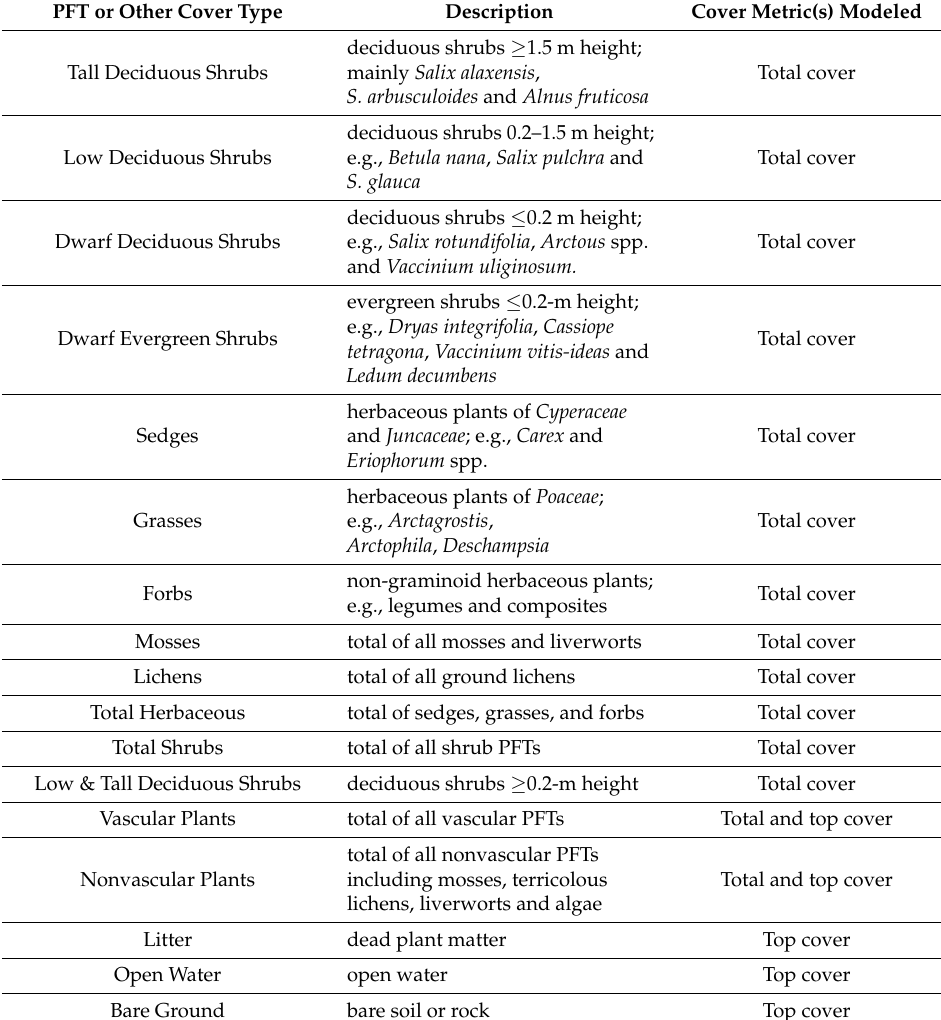
Table 1. Tundra PFTs and other cover types used for cover modeling, North Slope,